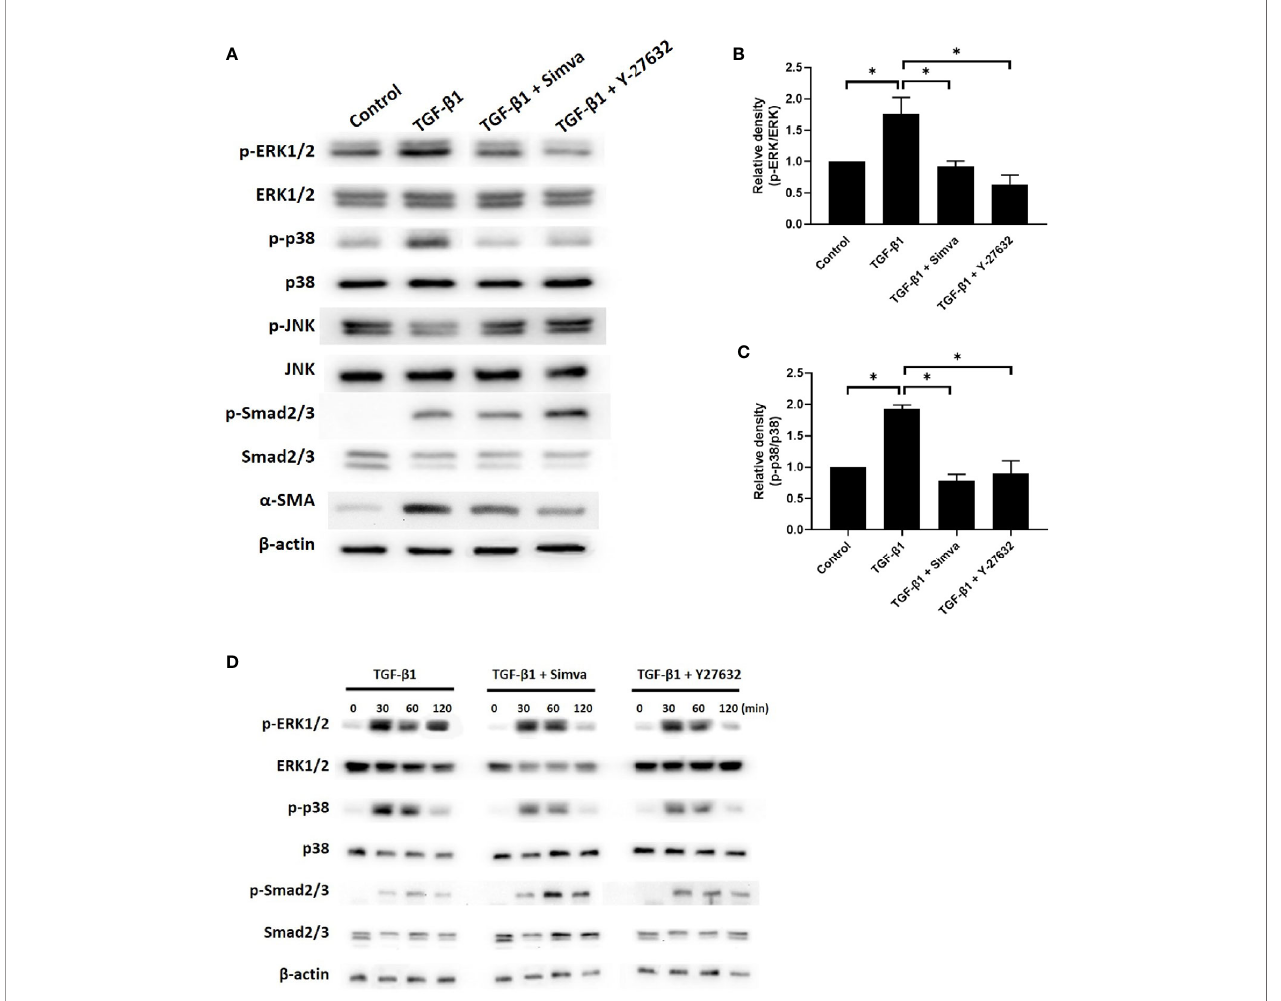
FIGURE 4 | Effects of simvastatin and ROCK inhibitor Y-27632 on transforming growth factor- b (TGF- b )-induced signaling. (A) Primary cultured Graves ’ ophthalmopathy (GO) orbital fi broblasts were stimulated with TGF- b 1 (3 ng/mL) for 48 h with or without a 1-h pretreatment with simvastatin (10 m M) or ROCK inhibitor Y-27632 (30 m M). The expression and phosphorylation levels of Smad2/3, ERK1/2, p38, and JNK were determined using western blot analysis. (B, C) The densities of ERK1/2 (B) and p38 (C) protein bands were quanti fi ed and normalized to b -actin. (D) GO orbital fi broblasts were stimulated with TGF- b 1 (3 ng/mL) for 30, 60, 120 min with or without a 1-h pretreatment with simvastatin (10 m M) or ROCK inhibitor Y-27632 (30 m M). The expression and phosphorylation levels of Smad2/3, ERK1/2, and p38 were determined using western blot analysis. Data are presented as mean ± SD of at least three independent experiments. *p <